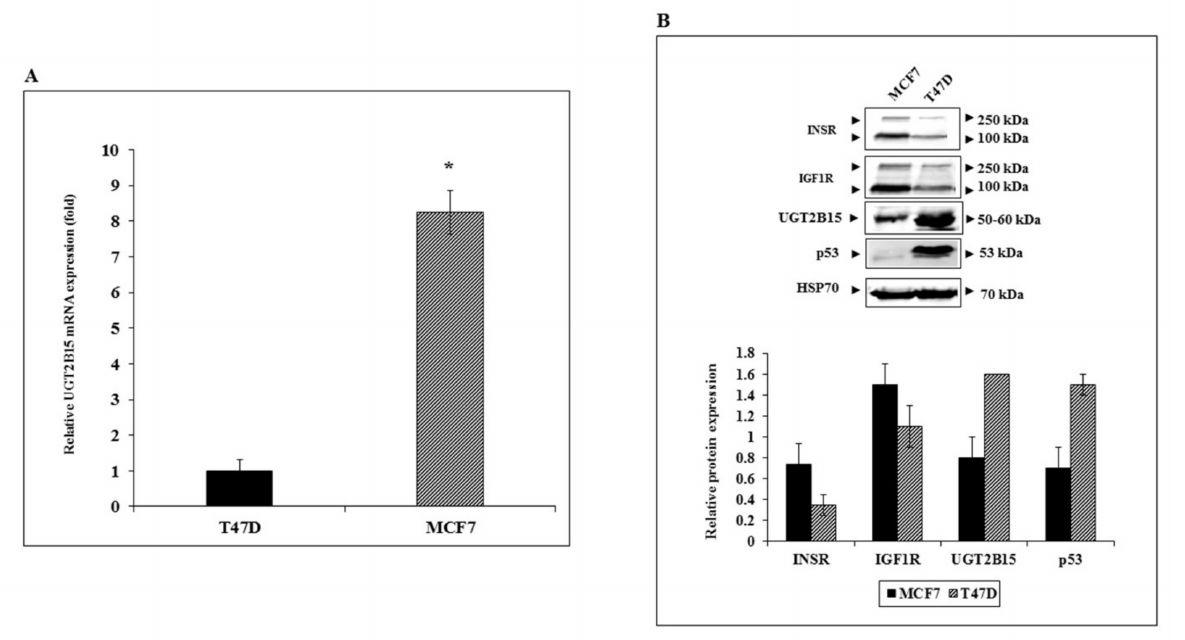
Figure 4. Expression of UGT2B15 in breast cancer cell lines. ( A ) Total RNA was obtained from confluent T47D and MCF7 cells and UGT2B15 mRNA levels were measured by RT-QPCR. A value of 1 was assigned to the UGT2B15 mRNA levels in T47D cells. * p < 0.01 vs. T47D cells. ( B ) Total protein was obtained from confluent T47D and MCF7 cell lines and UGT2B15, IGF1R, INSR, and p53 protein levels were measured by Western blots. Relative protein levels are expressed as protein levels normalized to the corresponding HSP70 value. Results of a representative experiment are shown, repeated three times with similar